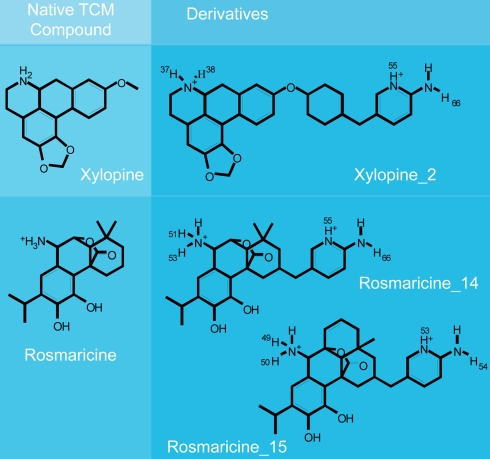
Structures of the top three de novo derivatives and their corresponding native TCM compounds.